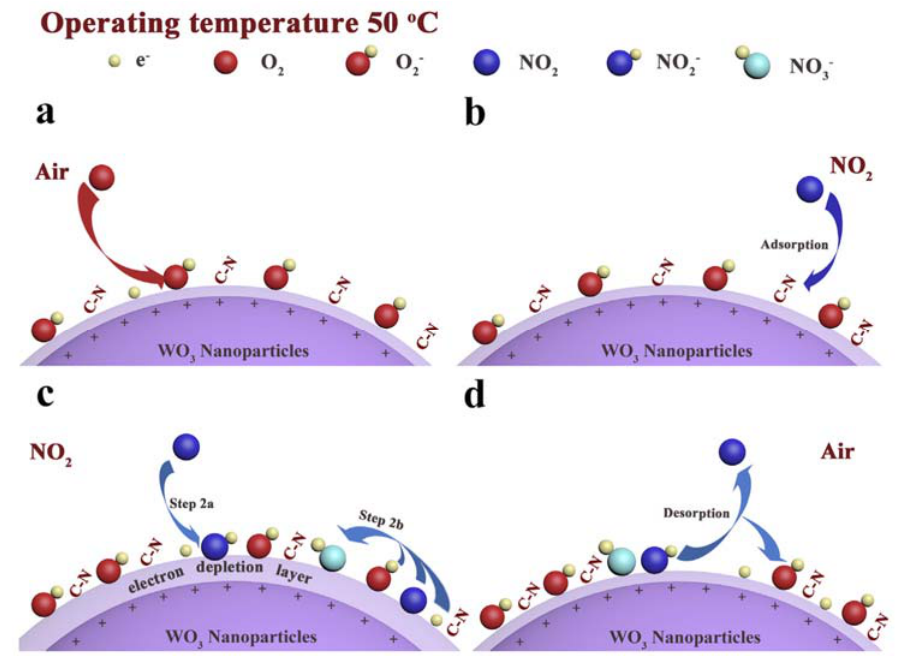
Figure 4. Proposed NO 2 detection mechanism. Reproduced with permission [117]. Copyright 2019, Elsevier.